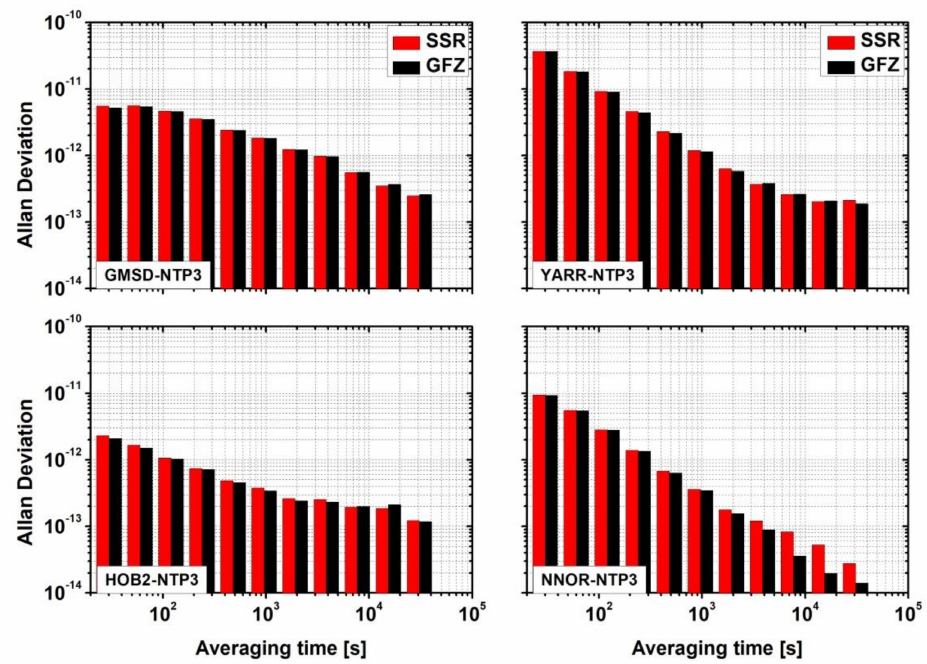
Figure 12. Galileo Allan deviation (ADEV) for SSR and GFZ